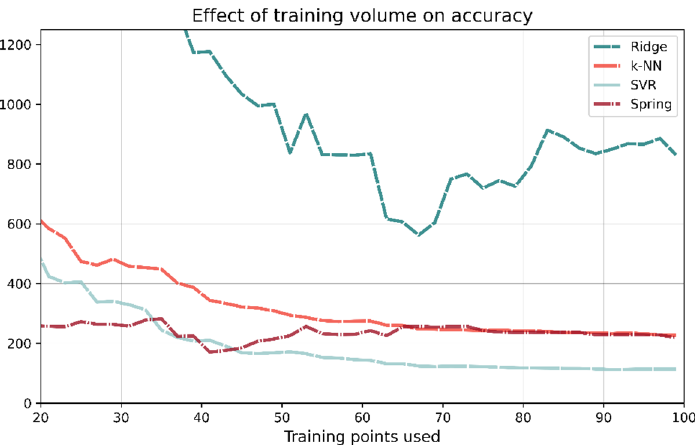
Figure 22. The number of training points used has a large impact on which model has the best performance. Despite being the best performing model when trained on the entire data set, Ridge regression requires a significant number of training data. It takes 1580 training points before Ridge regression becomes the best performing model.